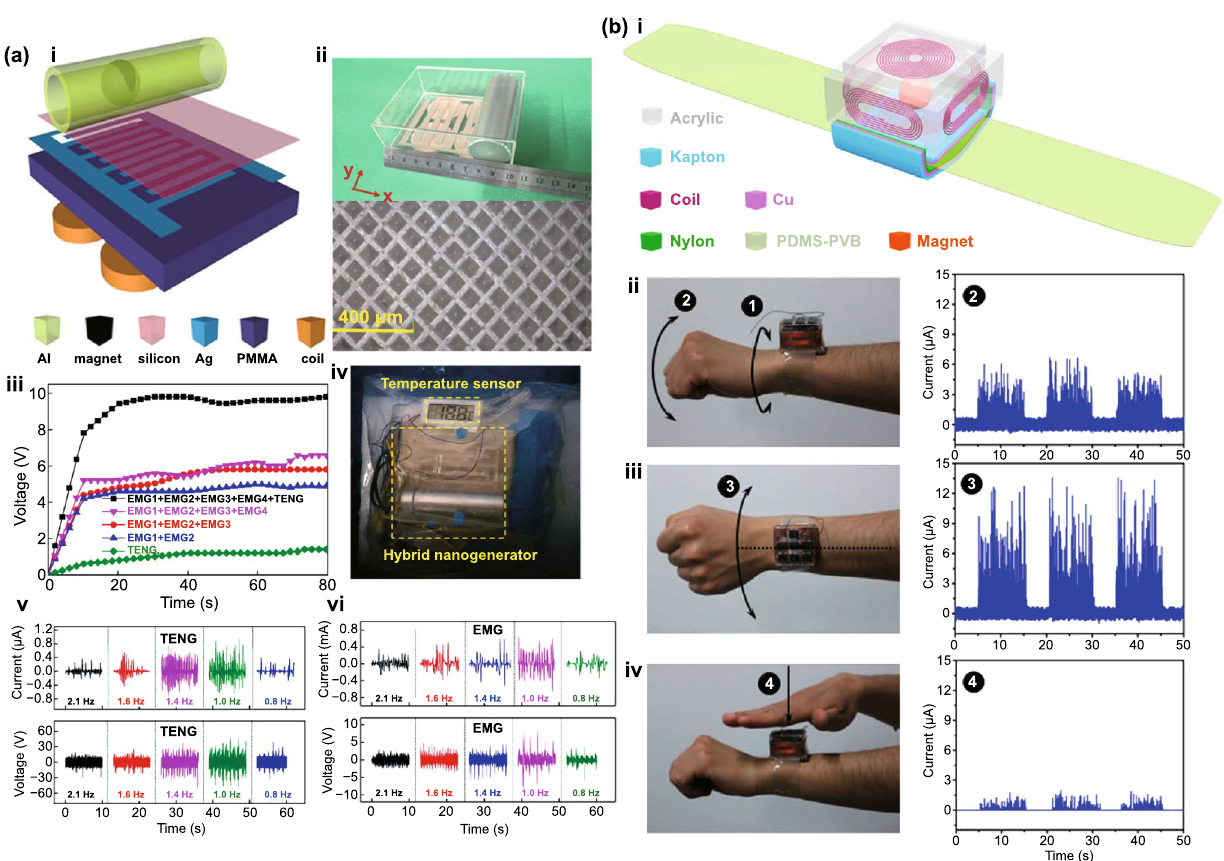
Fig. 26 a (i) Schematic diagram of the two-dimensional wave energy hybrid harvester developed by Hao et al. (ii) Picture of the hybrid nano- generator and SEM image of the silicone thin film with pyramidal structures. (iii) Charging curves of a 10 μF capacitor by the nanogenerator at a frequency of 1.5 Hz. (iv) Thermometer powered by the hybrid nanogenerator under the conditions of water wave vibration. SC current and OC voltage of the (v) TENG and (vi) EMG under different water wave frequency. Reproduced with permission from Ref. [104]. Copyright 2019, Elsevier Ltd. All rights reserved. b (i) Schematic diagram of the three-dimensional magnetic ball-based bracelet hybridized nanogenerator designed by Quan et al. (ii) Photograph of three different wrist motion types and corresponding output current signals. Reproduced with